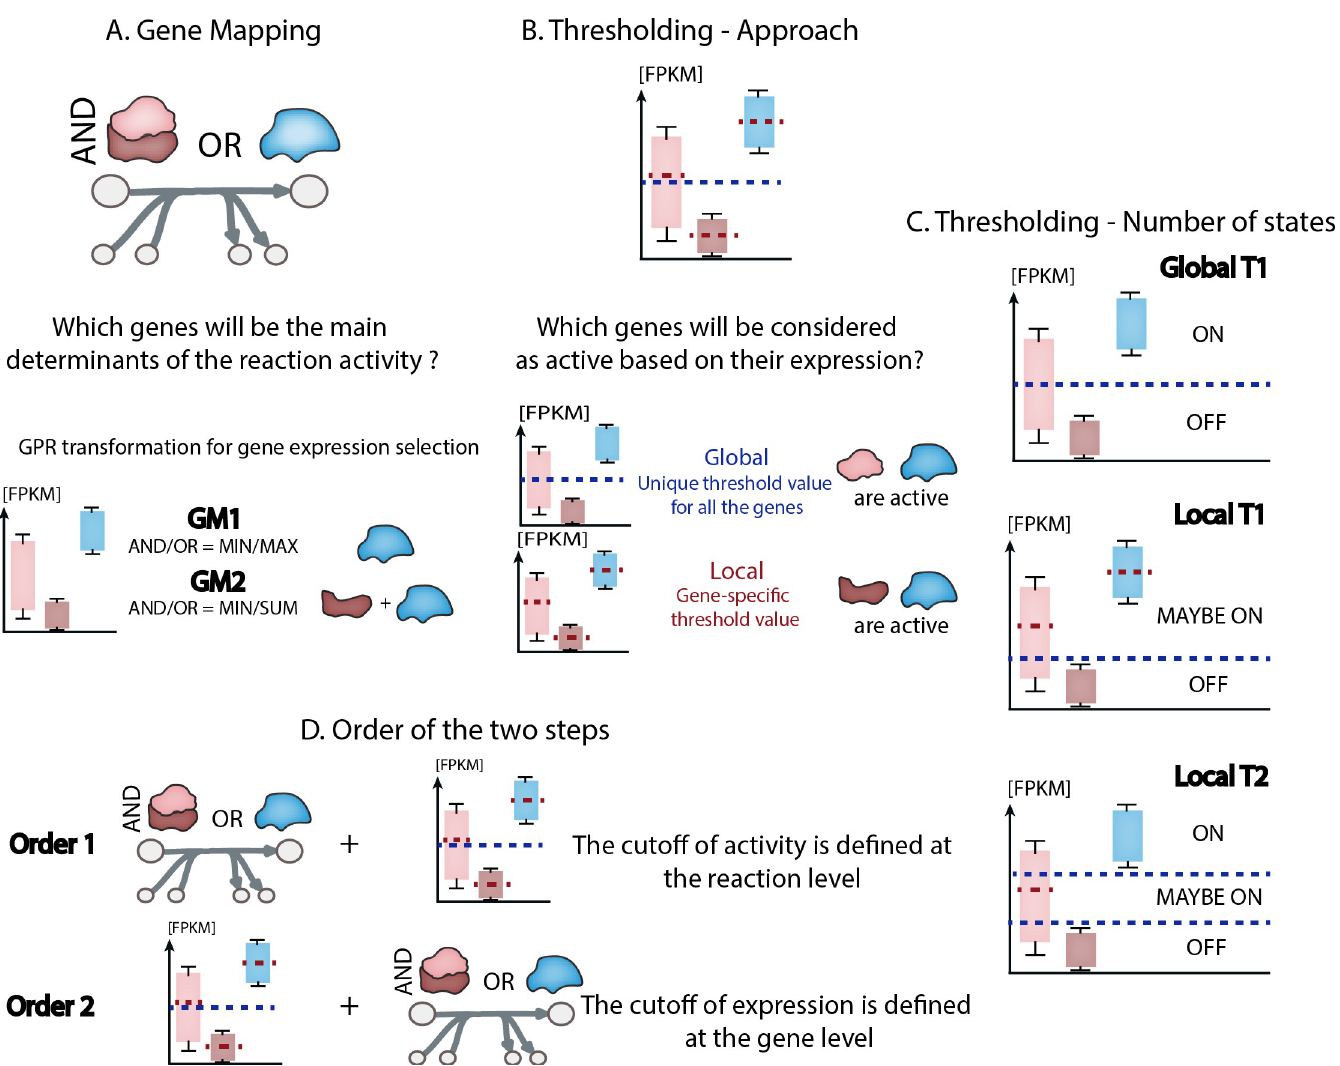
Fig 1. Formulation and implementation of preprocessing decisions. (A) Two types of gene mapping methods (GM1 and GM2) are compared. (B) Two types of thresholding approaches (global and local) are compared. (C) Formulation of three combinations of number of states (Global T1, Local T1, and Local T2) (D) Decisions about the order in which thresholding and gene mapping are performed. For Order 1, gene expression is converted to reaction activity followed by thresholding of reaction activity; for Order 2, thresholding of gene expression is followed by its conversion to reaction activity.